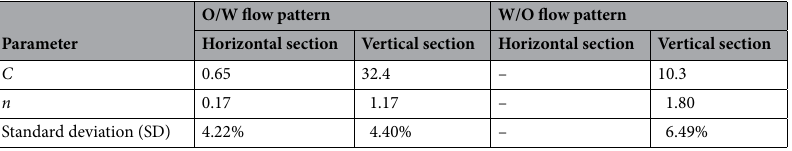
Table 3. The values of C and n for experimental data predicted by using the drift-flux